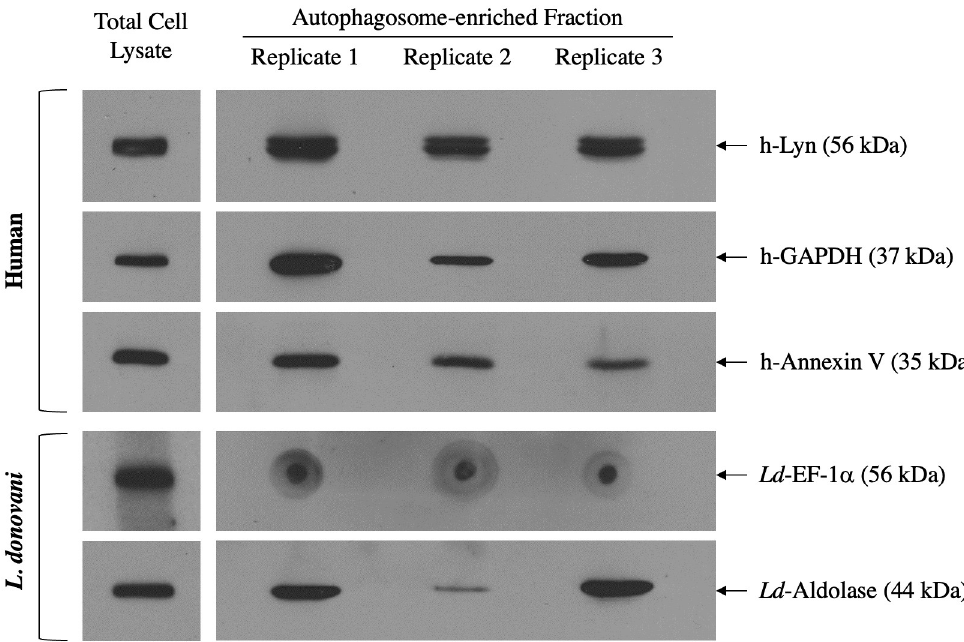
Fig 2. Validation of proteins identified by mass spectrometry analysis. Western blots of human Lyn, Annexin V, GAPDH, and Leishmania fructose bisphosphate aldolase ( Ld -aldolase) from autophagosome-enriched fraction four as well as a dot blot of Leishmania EF-1 α ( Ld -EF-1 α )from autophagosome-enriched fraction four (n = 3). Western blots for the respective proteins from total cell lysates were used as a positive control.